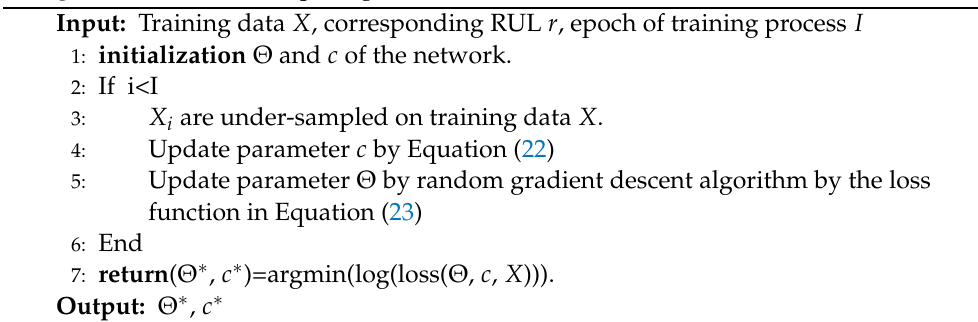
Algorithm 1: Down-sample algorithm based on